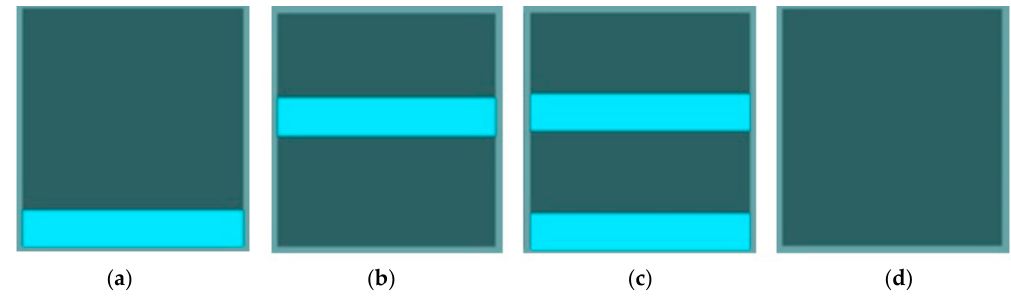
Figure 3. Four types of beat style: ( a ) a quarter note; ( b ) a quarter note (back beat); ( c ) two eighth notes; and ( d ) no beating point.